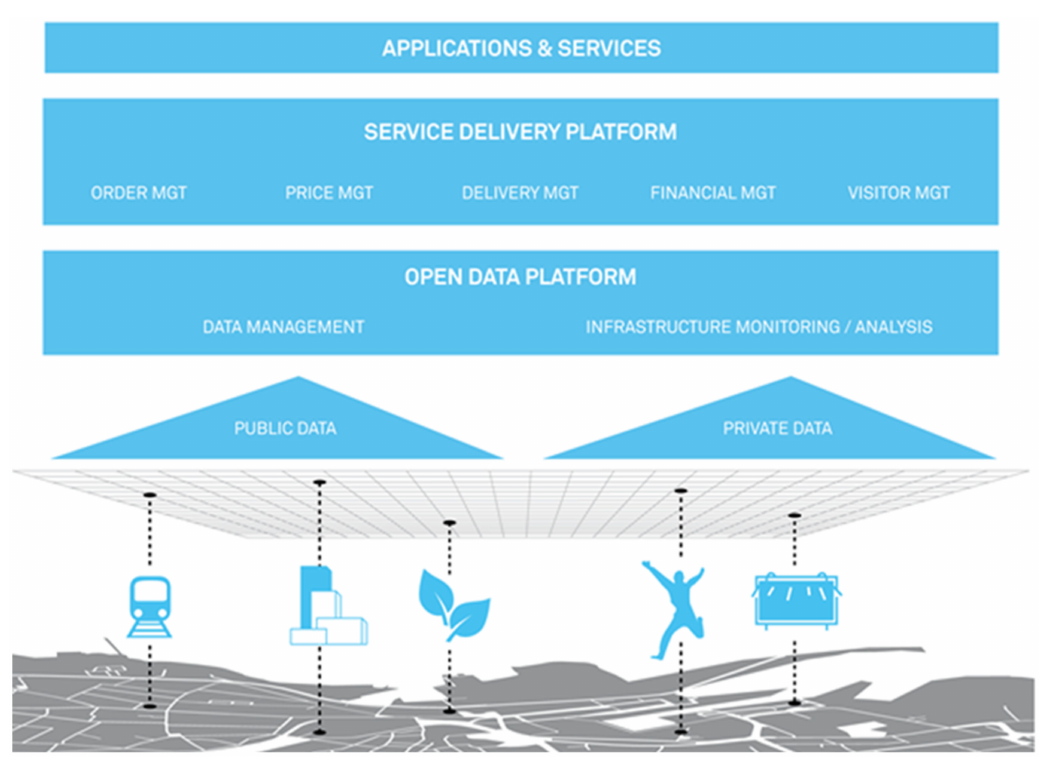
Figure 1. The Urban Open